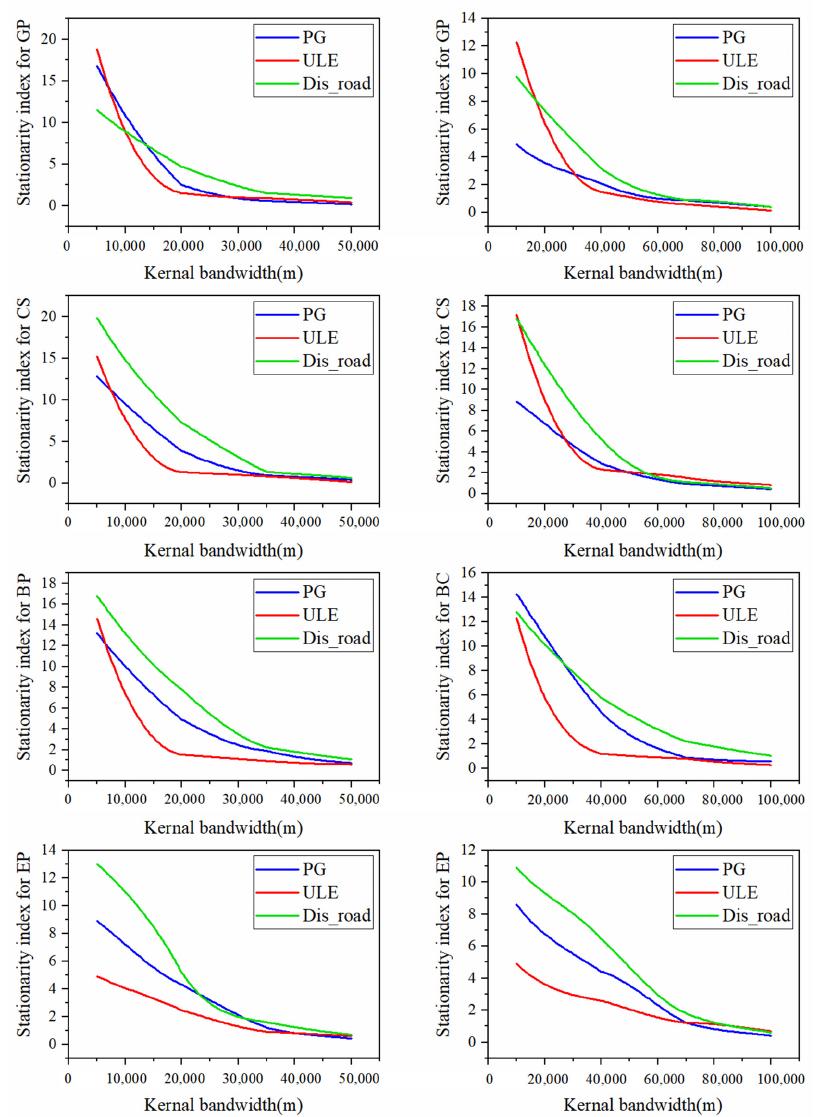
Figure 5. Correlogram between stationarity index and kernel bandwidth in GWR at 5 km ( left column ) and 10 km ( right column ) grid scales. Abbreviations: Grain productivity (GP); Carbon sequestration (CS); Biodiversity potential (BP); Erosion prevention (EP); Population growth (PG); Urban land expansion (ULE); Distance to major roads (Dis_road).